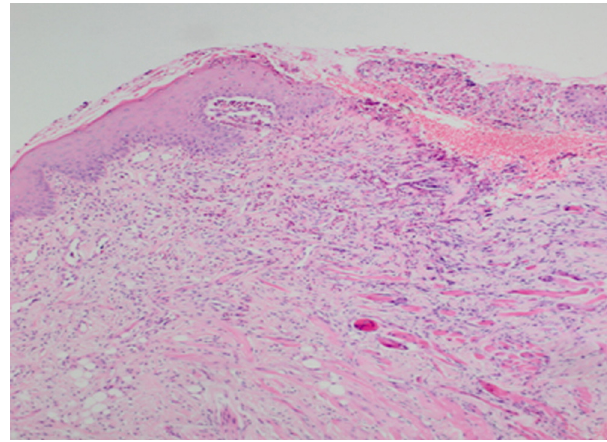
Figure 5 Ulceration of the mucosa (H---E 100 × ). inflammation was 2.85 (Fig. 3). There was increased inflam- mation compared with group